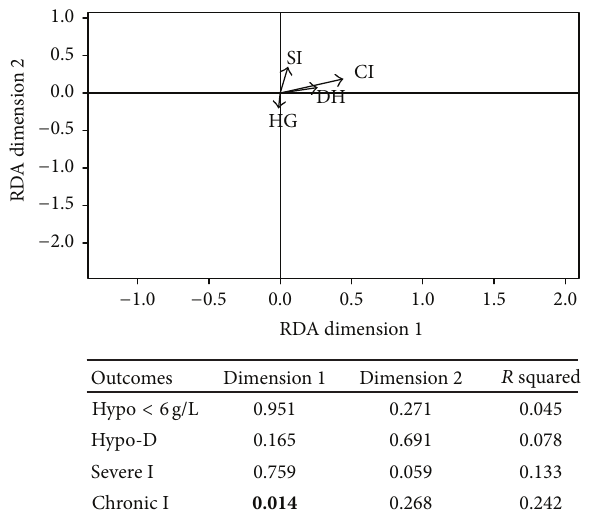
associated with low 𝑅 squared, as observed in our